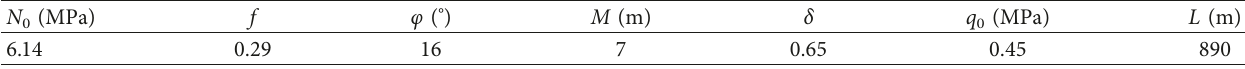
Table 2: Other parameters (apart from KS) in the method used to calculate abutment pressure.